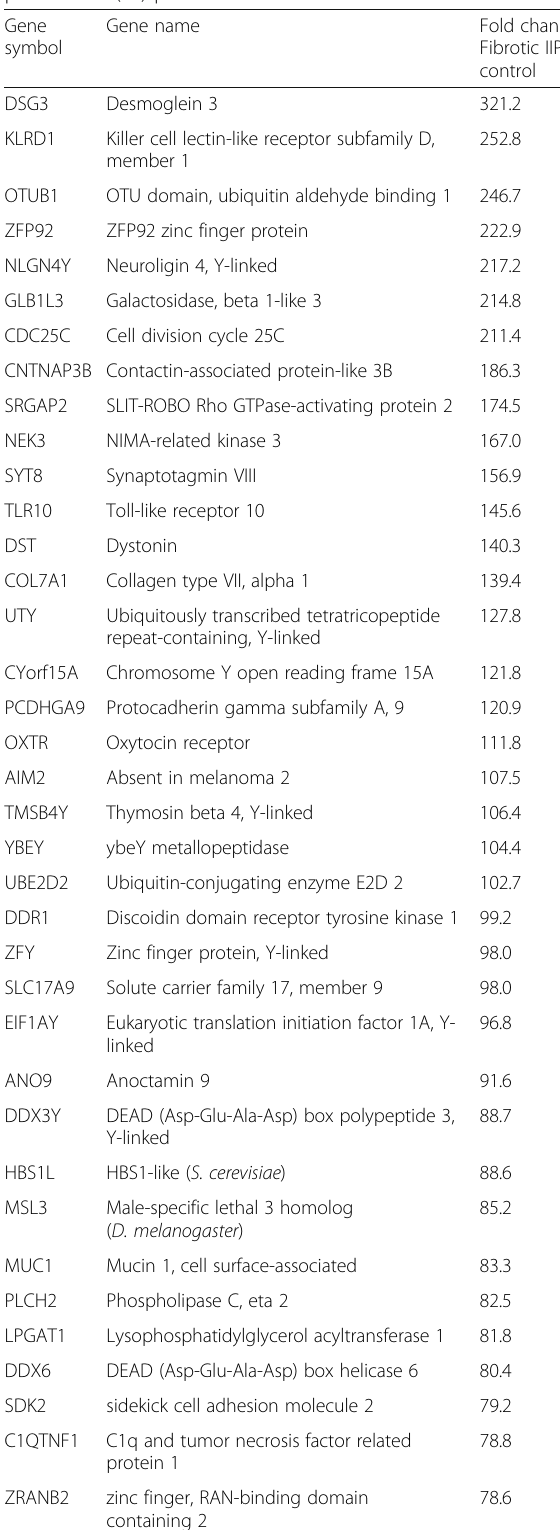
Table 2 Top 50 genes upregulated in idiopathic